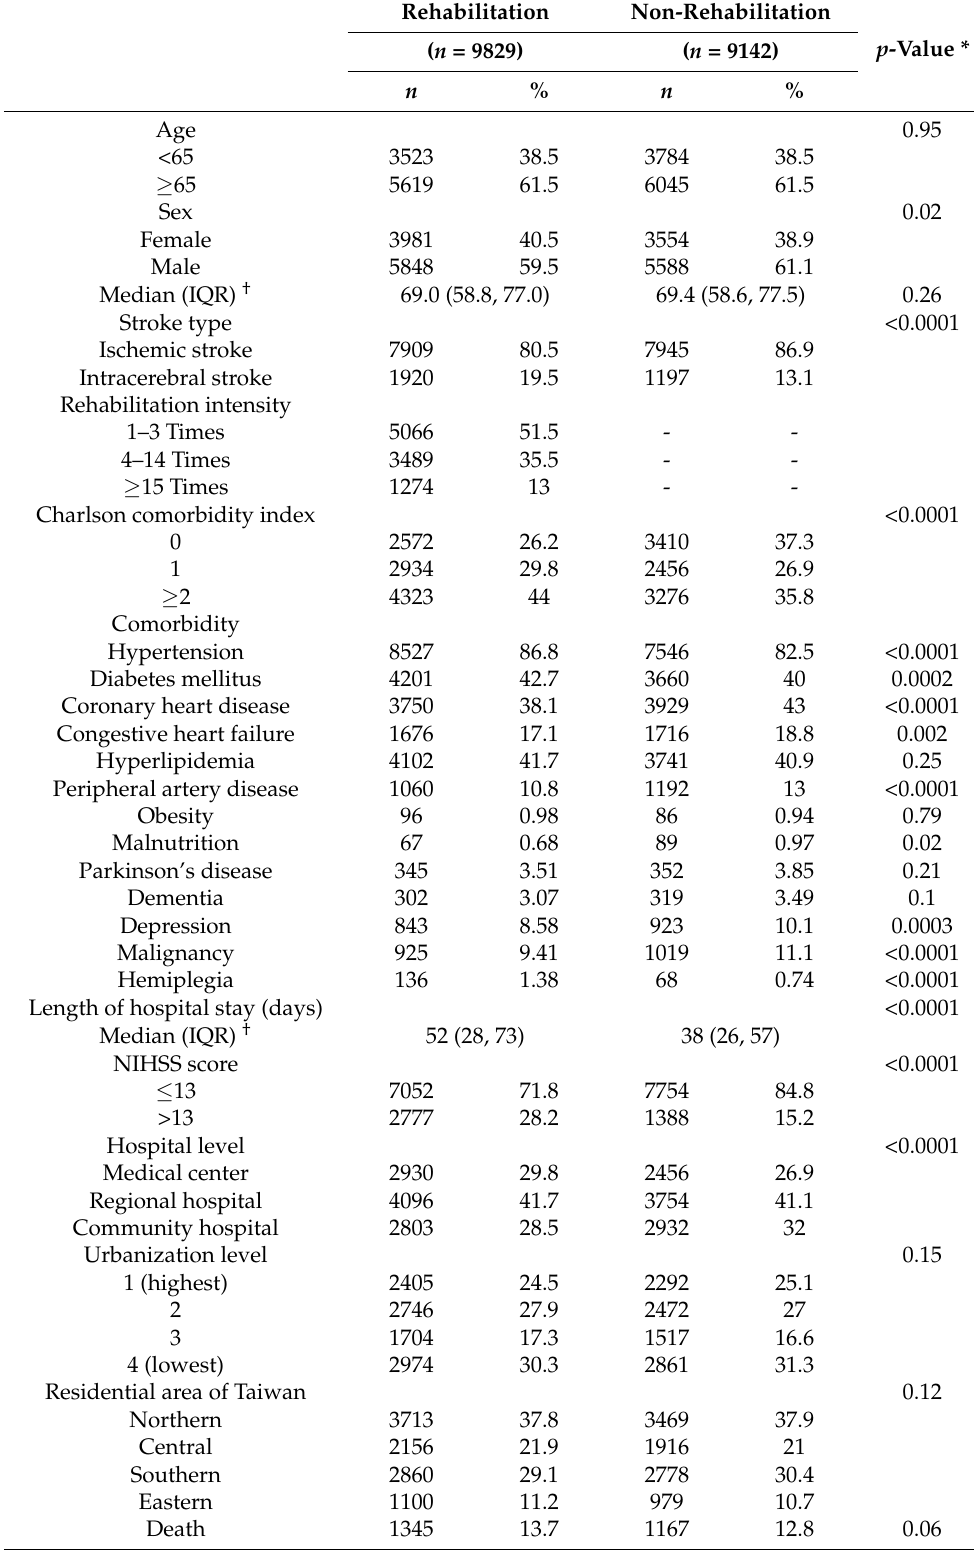
Table 1. Baseline characteristics and comorbidity of patients with and without post-stroke rehabilitation.